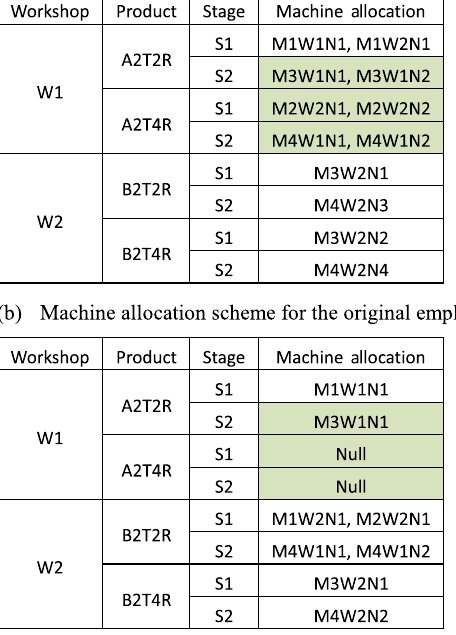
Table 4 Illustrative example of the LSO Workshop Product Stage Machine allocation